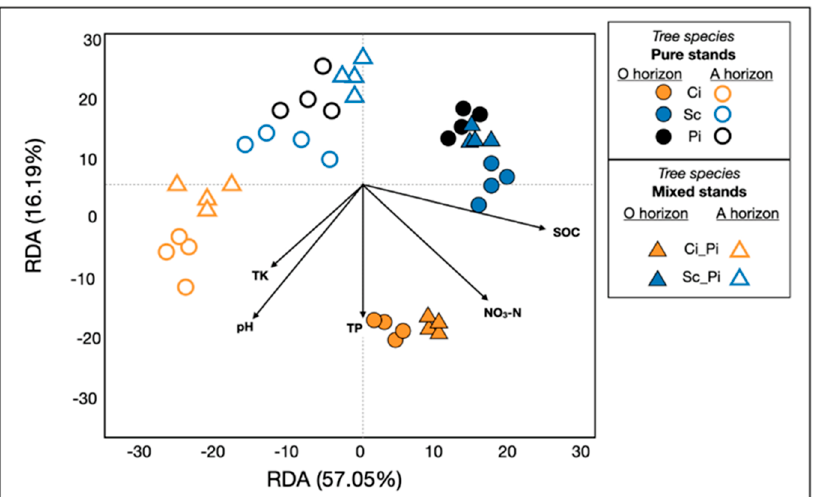
Figure 4. Redundancy analyses revealed soil bacterial communities in different forest types, their response to soil acidification, and the extent to which they correlated with edaphic properties. SOC, soil organic matter; TK = total potassium; TP = total phosphorus; NO 3 _N= nitrate. As in Figure 3, samples of pure stands (circles) and mixed stands (triangles) are colored by tree species: pure and mixed stands of Ci (orange); pure and mixed stands of Sc (blue); pure stands of Pi (black). Closed shapes indicate samples from O horizons; open shapes represent soils collected in A horizons.